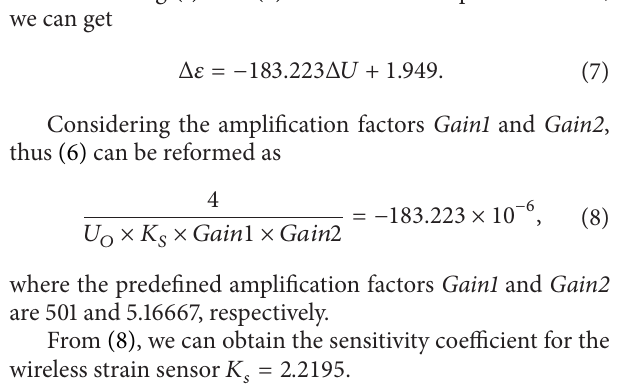
Figure 15: IRIS mote and MIB520.